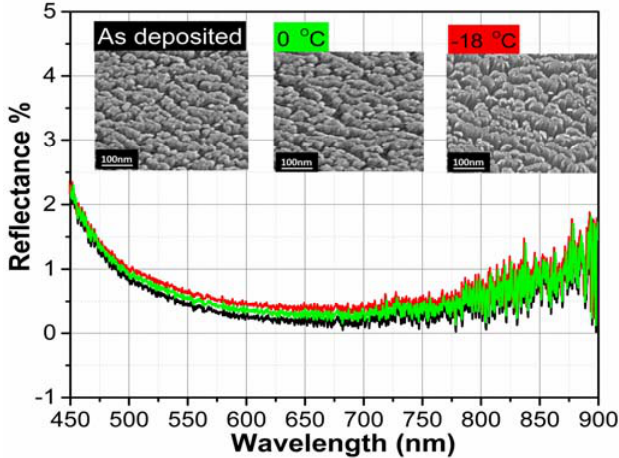
Figure 7. Experimentally calculated AR efficiency of as ‐ deposited nanozigzag SiO 2 AR coating and cold storage SiO 2 coating at 0 °C, and − 18 °C, The inset represents the top morphology of as ‐ deposited AR and negative temperature exposed SiO 2 AR coating.